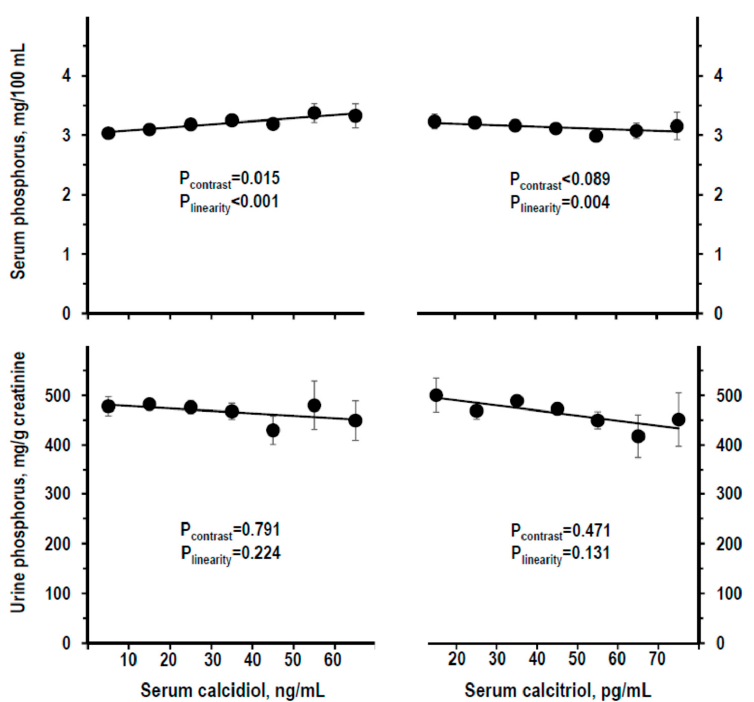
Figure 4. Mean ± SE of serum phosphorus (top panels) and of urine phosphorus / creatinine ratio